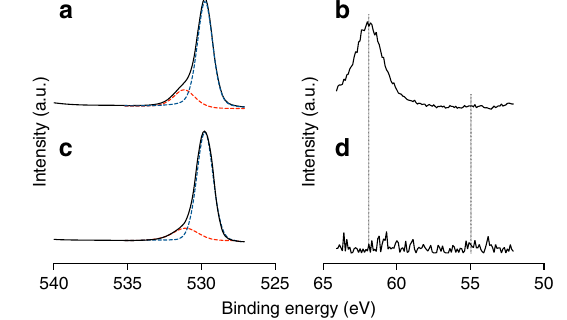
Figure 1 | X-ray photoelectron spectroscopy. Doped and undoped mesoporous TiO 2 layers for the O 1s peaks Li doped ( a ) and the undoped control ( c ), Ti 3 s and Li 1 s peaks slightly visible at 55eV for Li-doped ( b ) and the signal for the undoped TiO 2 here shown as reference, which reveals the absence of the peaks related to Ti 3 s (dashed line at 61.5eV) and Li 1 s ( d ), dashed line at